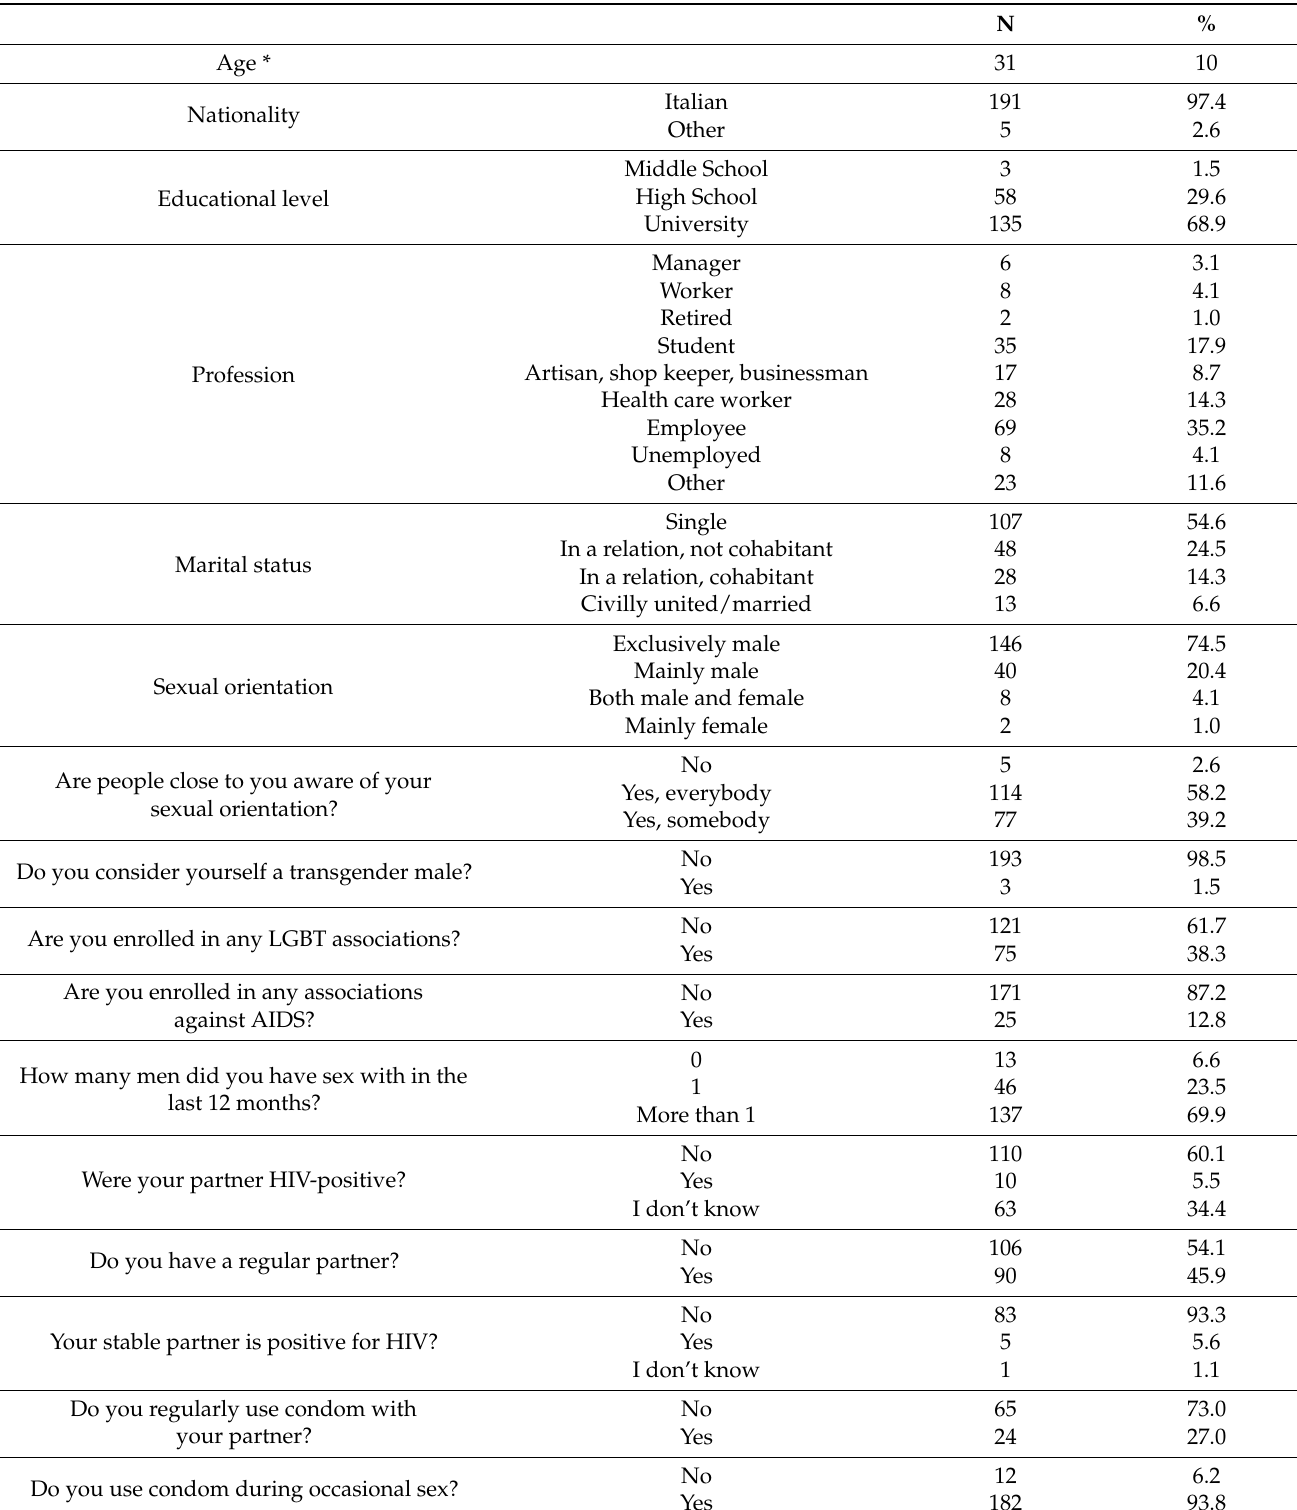
Table 1. Description of the sample (N =